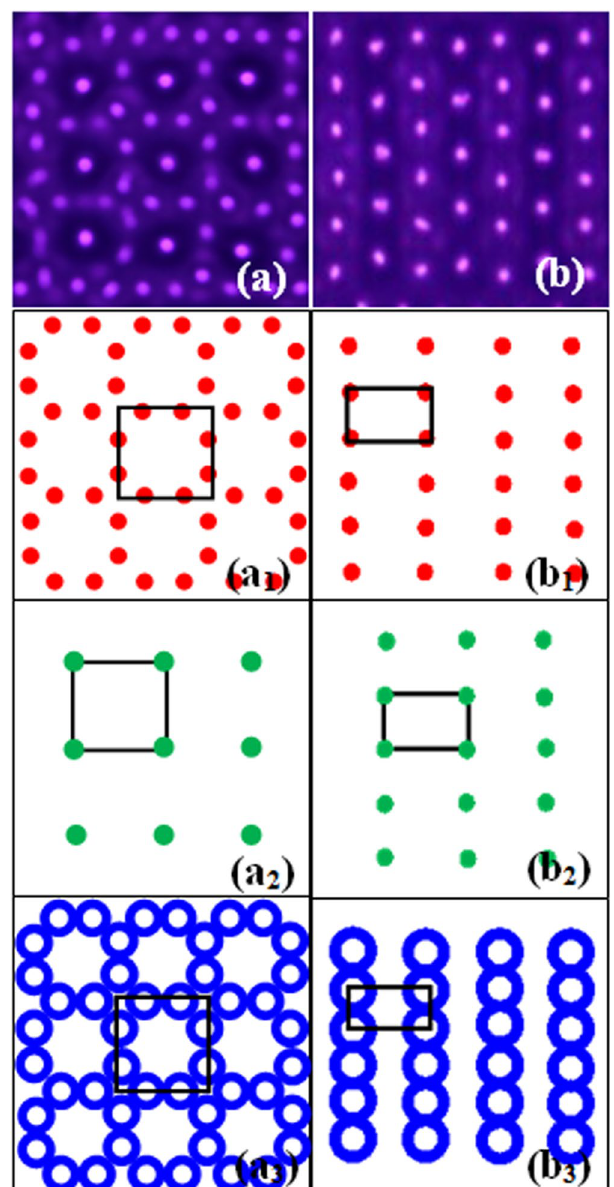
Figure 4. Schematic diagrams of the white-eye square grid state and the complex pattern with hexagonal lattice and white-eye stripe. ( a ) The white-eye square grid state. (a 1 –a 3 ) Are the different sublattices of the white-eye square grid state. ( b ) The complex pattern with hexagonal lattice and white-eye stripe. (b 1 –b 3 ) Are the different sublattices of the complex pattern with hexagonal lattice and white-eye